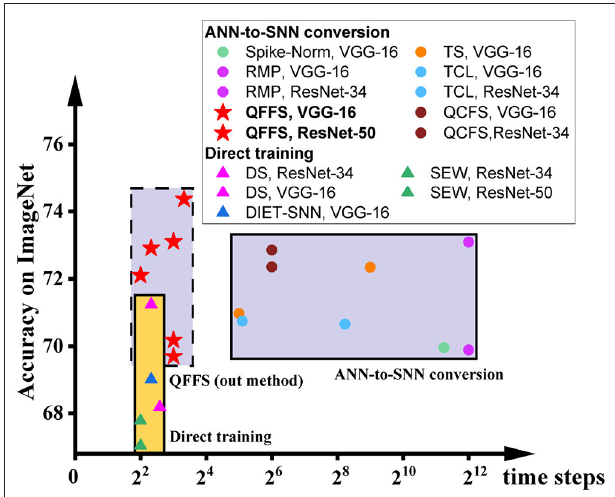
FIGURE 1 | The accuracy and latency of SNNs built by different methods: Spike-Norm ( Sengupta et al., 2019), TS (Deng and Gu, 2021), RMP (Han et al., 2020 ), TCL (Ho and Chang, 2020), QCFS (Bu et al., 2021) DS (Li et al., 2021b ), SEW (Fang et al., 2021), DIET-SNN (Rathi and Roy, 2020), and QFFS proposed in this paper. ANN-to-SNN conversion delivers high accuracy, and direct training delivers low latency. The proposed QFFS approach pushes the latency, when using ANN-to-SNN conversion, to a level similar to that using direct training. Also, our method shows about 2.5% higher accuracy than the best accuracy achieved by direct